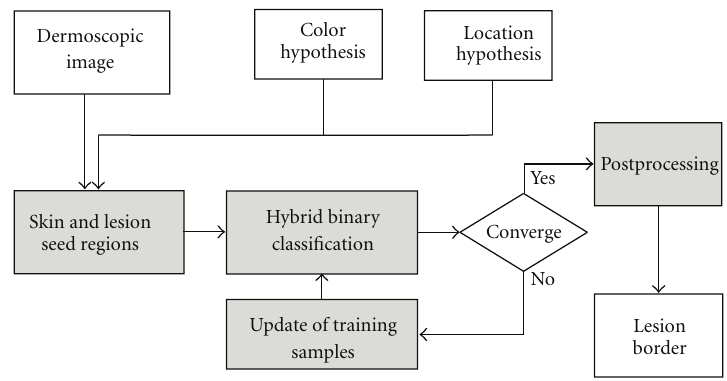
Figure 1: A flowchart of the proposed ICS algorithm showing the main processing